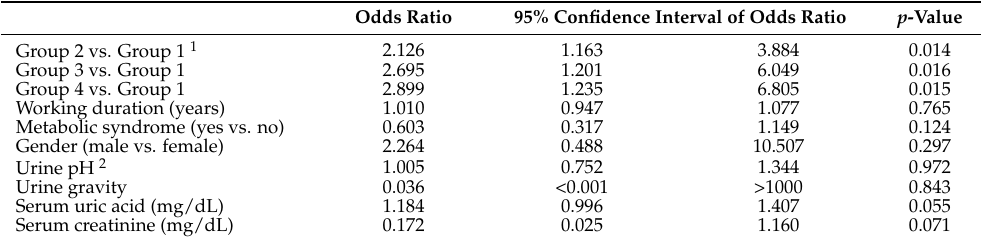
Table 4. Logistic regression of radiolucent stones predicted by working duration, metabolic syndrome, gender, urine pH, urine gravity, serum uric acid, and serum creatinine following grouping by age and heat exposure. Odds Ratio 95% Confidence Interval of Odds Ratio p -Value Group 2 vs. Group 1 1